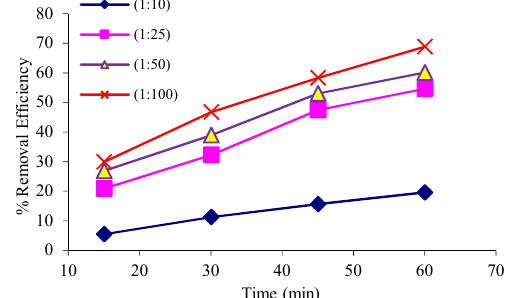
Fig. 7. Effect of initial leachate concentration on COD